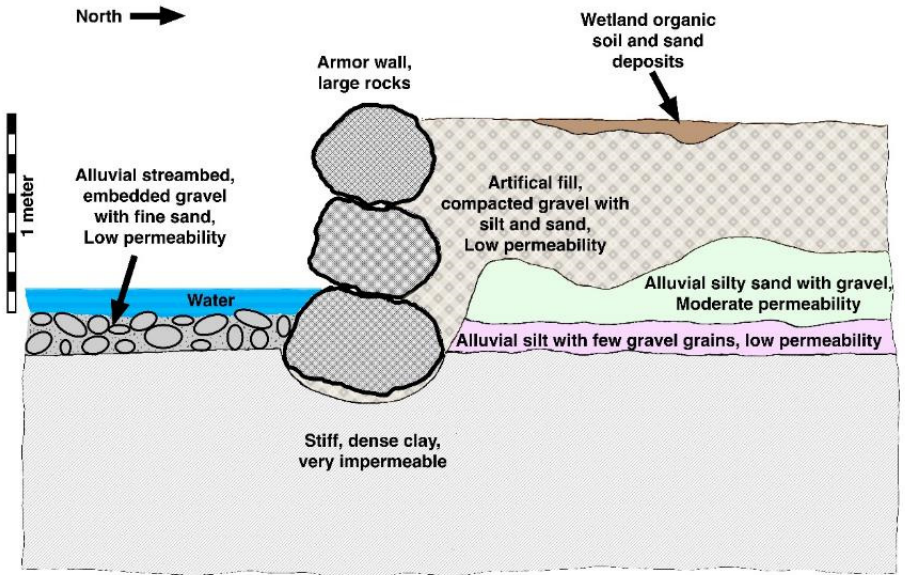
Figure 2. Schematic pre-construction substrate cross section at the Kingfisher Treatment site, looking upstream with channel center at left.